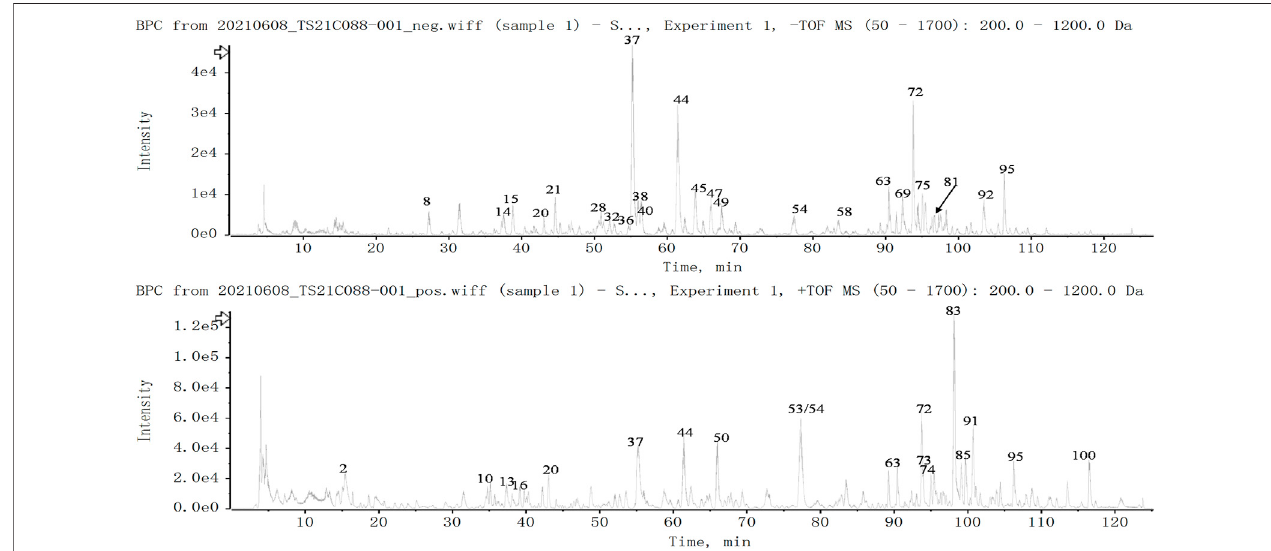
FIGURE 1 | Total ion chromatogram of constituents in HZRG. Agilent 1290 UPLC system was applied to analyze the chemical pro fi ling of HZRG granules, data were collected under both negative ion mode and positive ion mode, and processed by Analyst Ver. 1.6